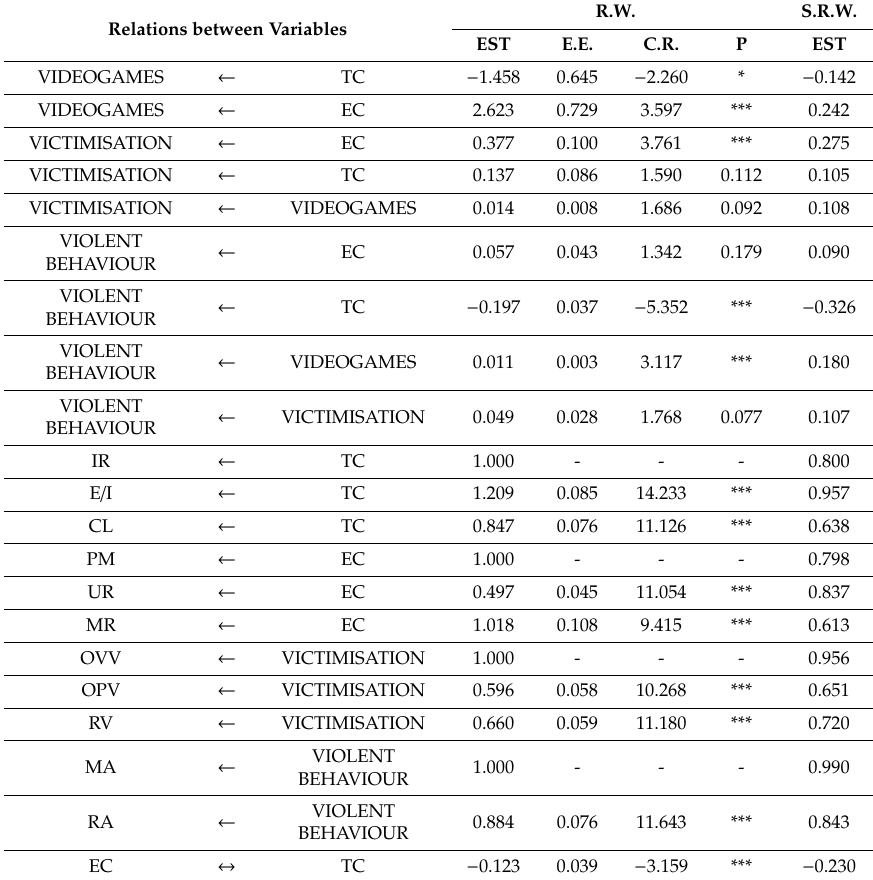
Table 2. Structural model in sedentary